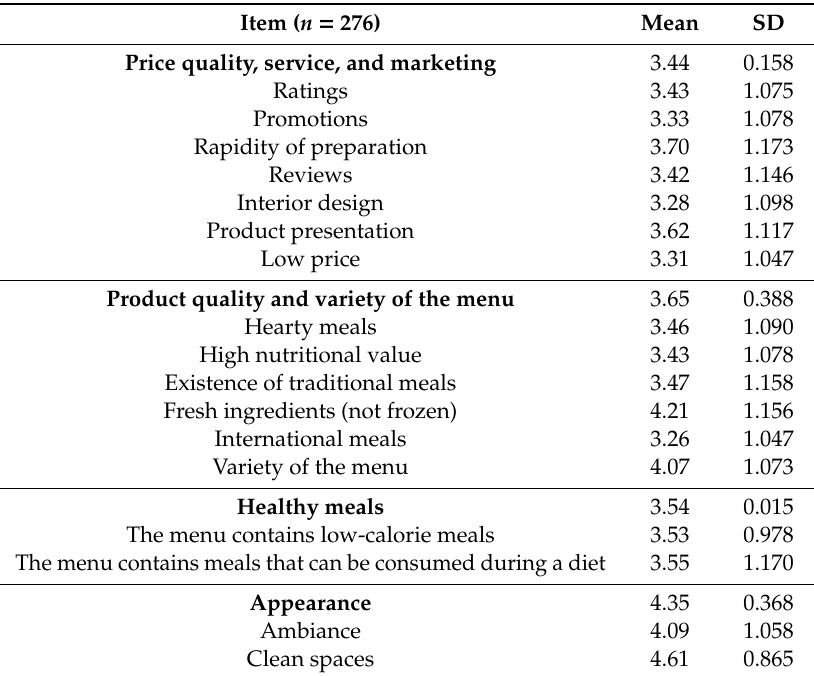
Table 4. Importance of factors in the selection of